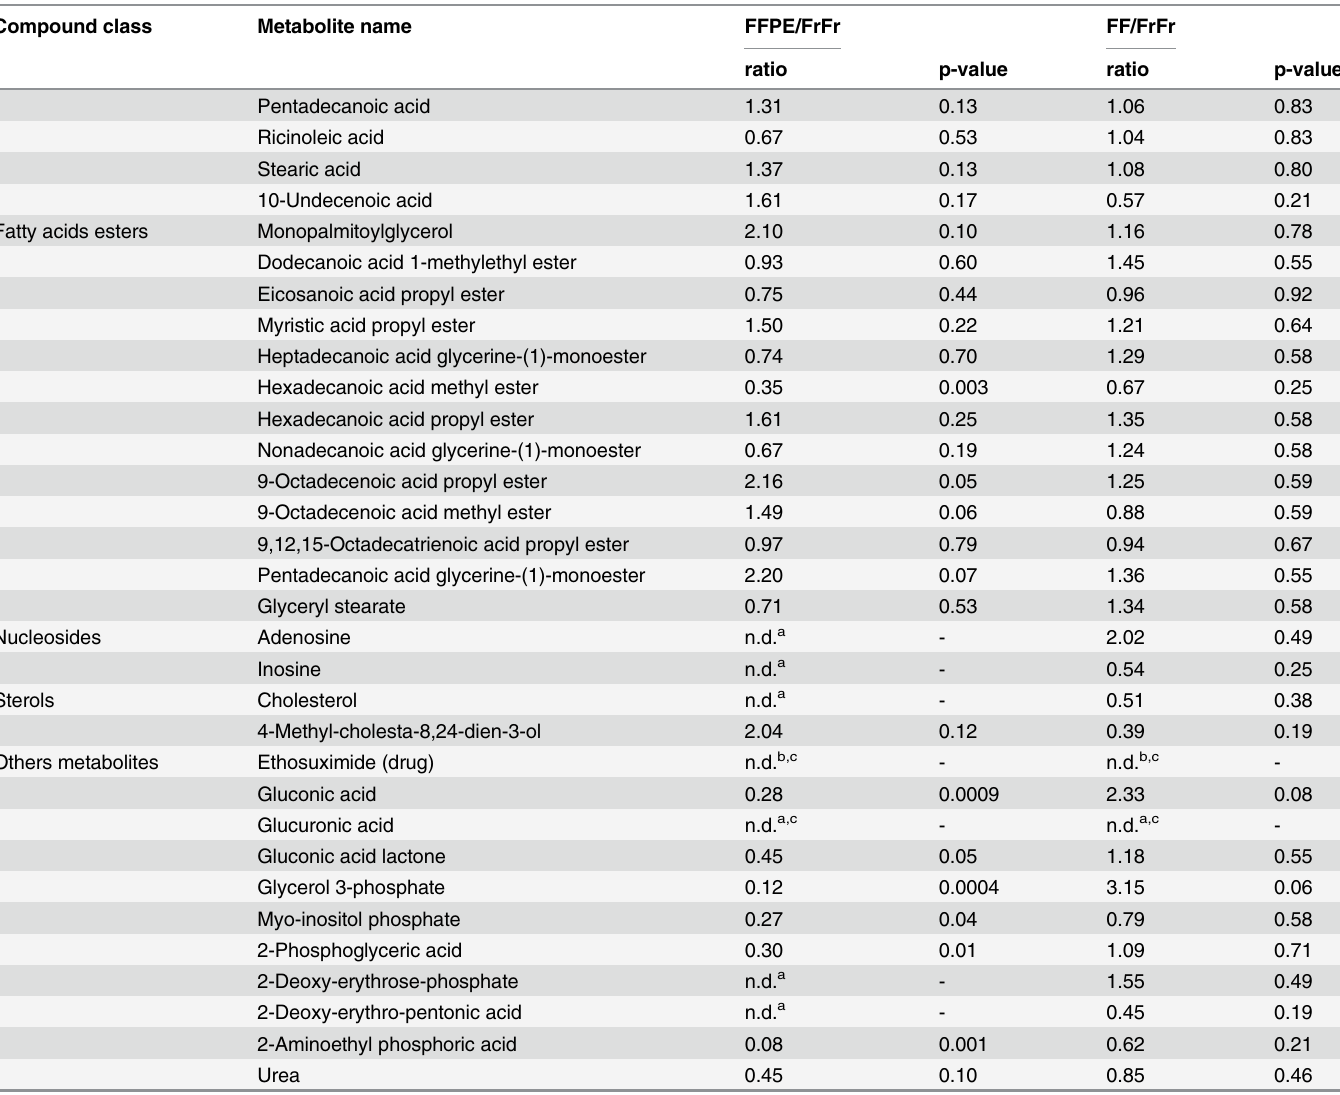
Shown are differences (fold-changes) in relative abundances of each metabolite between FFPE or formalin- fi xed (FF) tissue specimens and fresh-frozen